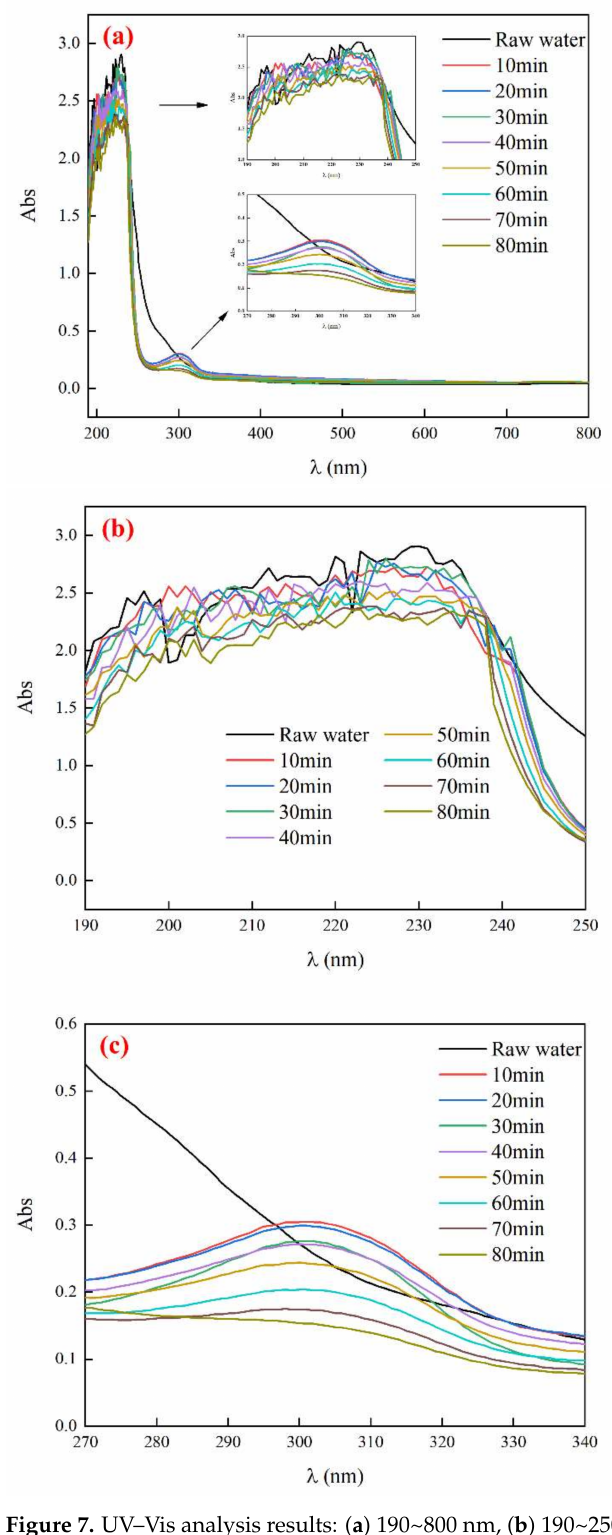
Figure 7. UV–Vis analysis results: ( a ) 190~800 nm, ( b ) 190~250 nm, ( c ) 270~340